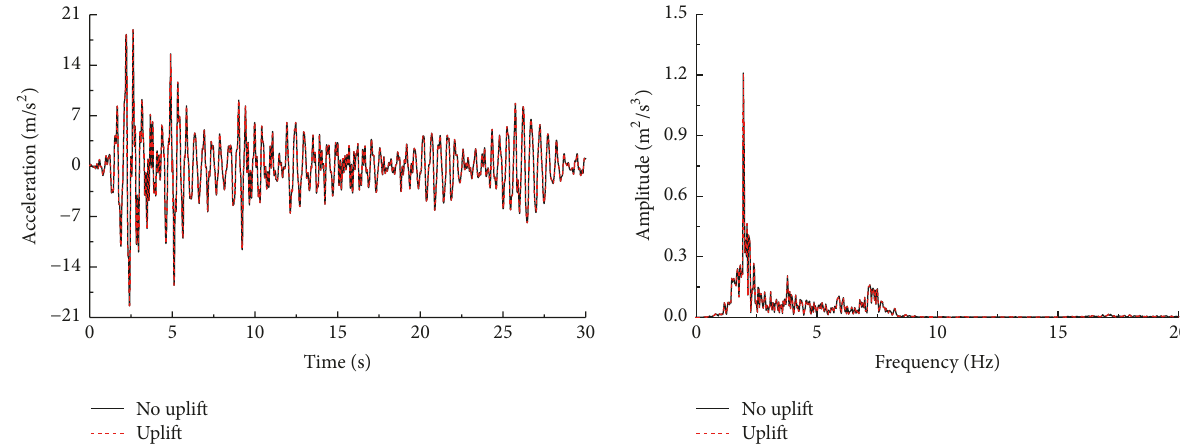
Figure 12: Horizontal acceleration time history and its Fourier spectrum curves at node 103 on the fourth floor under standard case